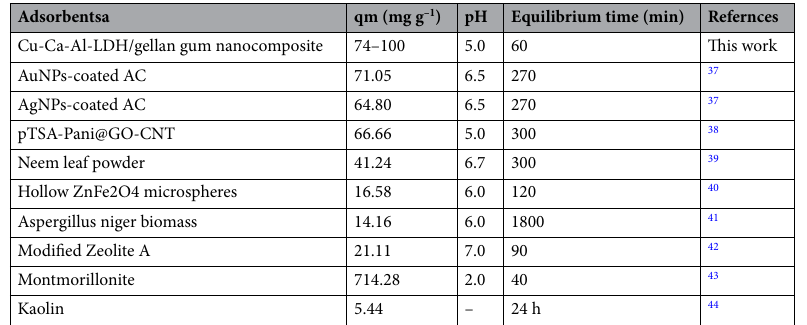
Table 4. Comparison of adsorption capacity, pH, and equilibrium time of the present method with other methods for removal of CR by reported adsorbents. a NPs: nanoparticles; AC: activated carbon; p TSA: para toluene sulfonic acid; Pani: polyaniline; GO: graphene oxide; CNT: multiwalled carbon